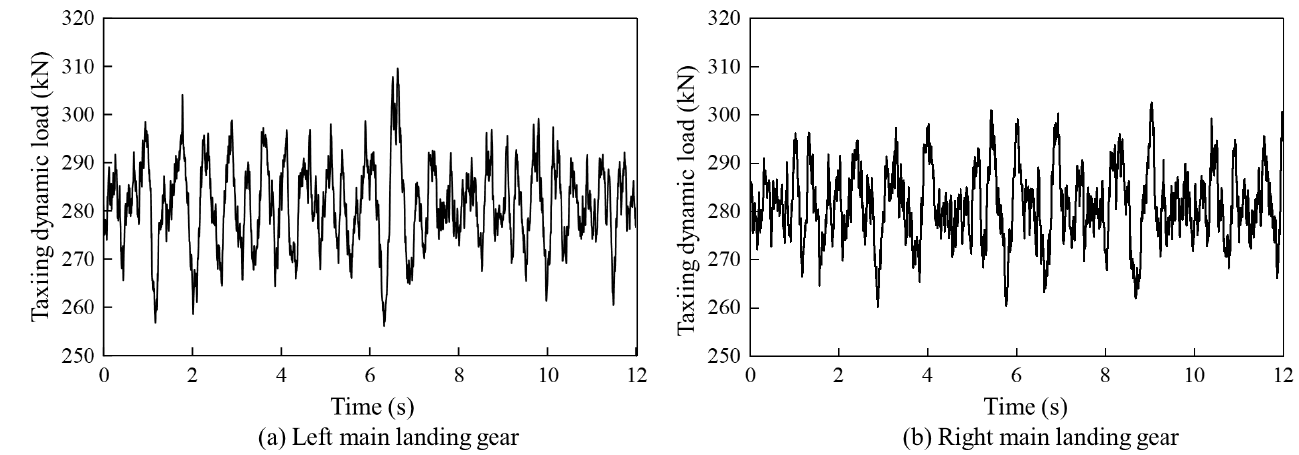
Figure 5. Dynamic load of aircraft main landing gear.